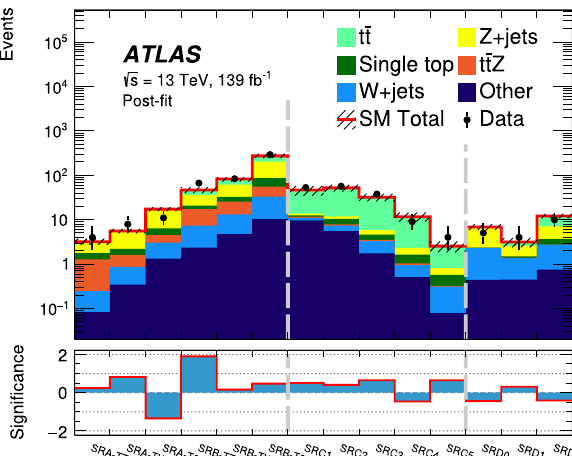
Fig. 10 The total number of data events (points) and the SM expecta- tion(stackedhistograms)inallvalidationregionsaftertheSRA–B,SRC and SRD background-only fits. The stacked histograms show the SM prediction and the hatched uncertainty band around the SM prediction shows the total uncertainty, which includes the MC statistical uncer- tainties, theory-related and detector-related systematic uncertainties. The lower panel shows the significance of the difference between data and the background prediction calculated with the method described in Ref. [122]. The validation regions considered in the SRA–B, SRC and SRD fits are separated by vertical dashed lines